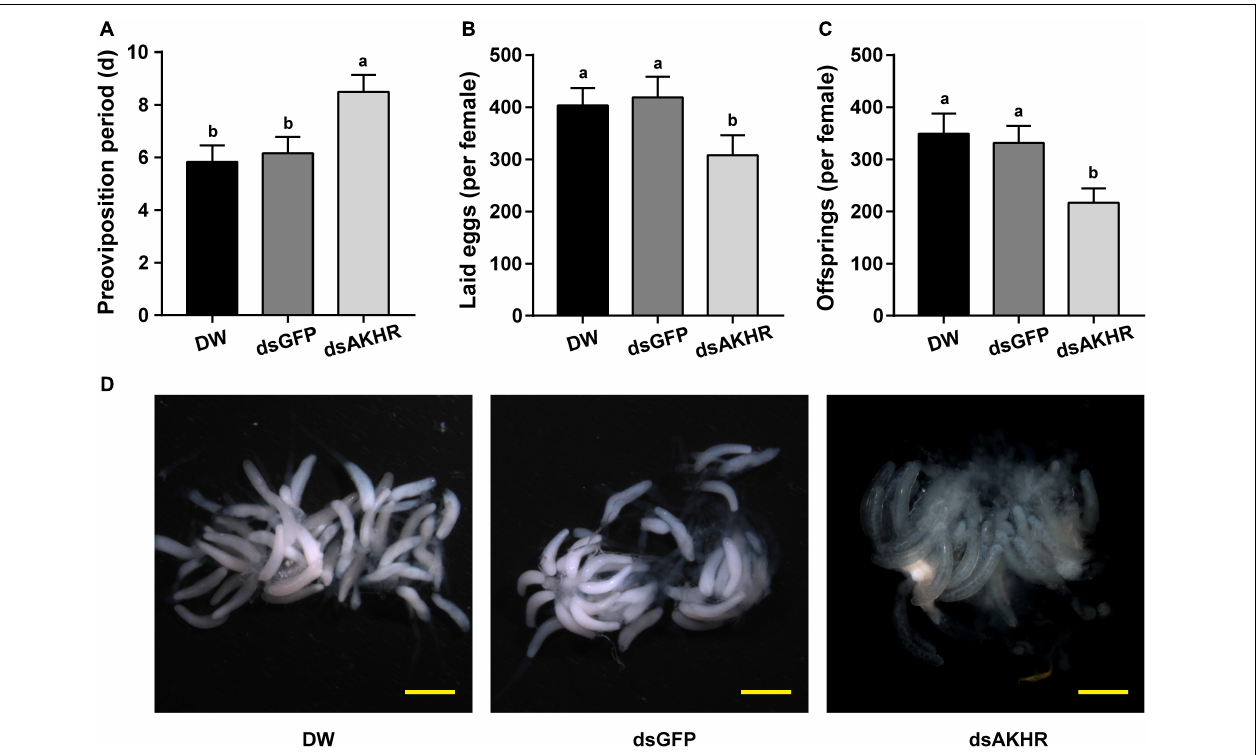
FIGURE 2 | Knockdown of NlAKHR decreases fecundity and leads to abnormal morphology of the ovary. Newly emerged females were injected with DEPC-treated water (DW) or dsRNA for NlAKHR or GFP (control) genes. Oviposition and fecundity were monitored after dsRNA injection. (A) Pre-oviposition periods were counted and (B) the eggs laid were collected after oviposition using microscopy ( n = 12). (C) Total offsprings produced by silenced and control females ( n = 12). The results are represented as means ± SE from three independent experiments. Different lowercase letters above the columns represent significant difference at P < 0.05 using one-way ANOVA followed by Duncan’s multiple comparison. (D) Representative images of ovaries from control and silenced females observed under a stereomicroscope. Scale bar, 500 µ